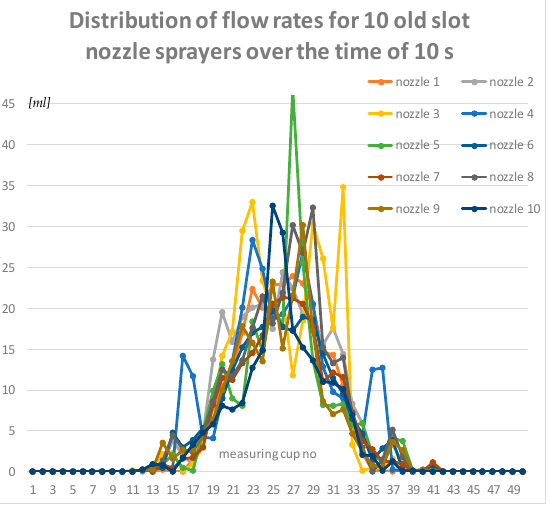
Figure 3. Distribution in 50 measuring cups of flow rates over the time of 10 s for 10 old flat fan nozzles from group A.